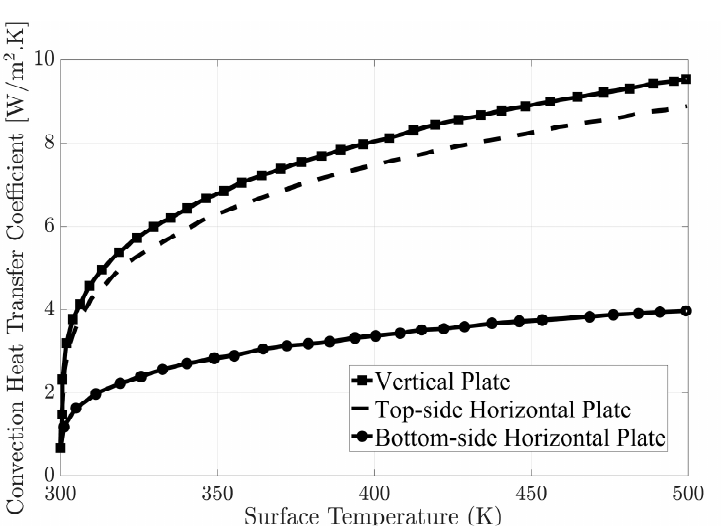
Figure 4. Heat transfer coefficient for free convection between the cold surrounding and hot plate